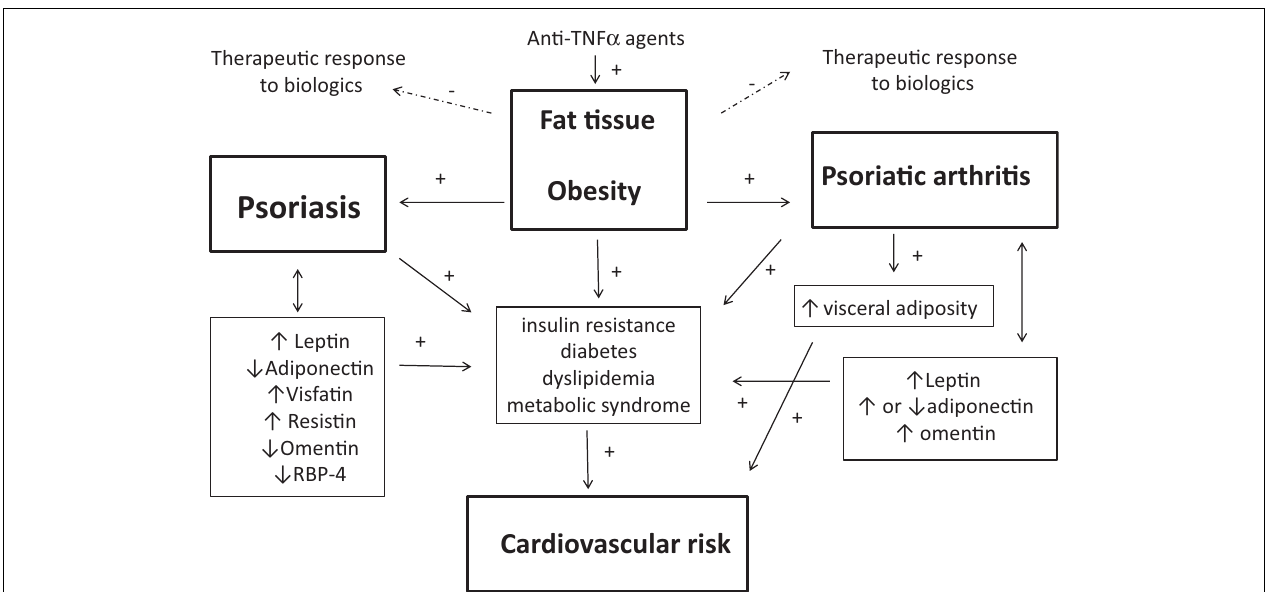
levels of the adipokines leptin, adiponectin, visfatin, resistin omentin, and retinol-binding protein-4 (RBP-4) have been found in patients with Pso or PsA. Leptin has pro-inflammatory effects and may contribute to skin and joint inflammation. Adiponectin promotes insulin sensitivity and its reduced level in Pso may drive insulin resistance and may lead to impaired cardiac and vascular protective effects, thus contributing to the CV risk. In addition, the excess of adipose tissue in Pso and PsA may compromise the therapeutic response to biological agents in Pso and PsA. Finally, anti-TNF α agents have been associated with weight gain in patients with Pso or